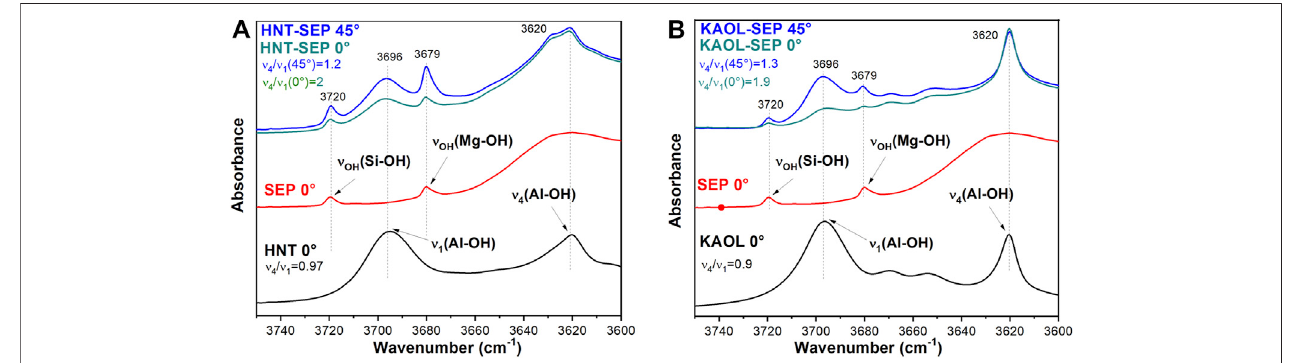
FIGURE8| FTIR spectraof (A) HNT-SEP1:2 fi lmat 0 ° (green) and45 ° (blue),purehalloysite (black)and sepiolite(red), and (B) KAOL-SEP 1:2 fi lmat0 ° (green)and 45 ° (blue), pure kaolinite (black) and sepiolite (red).